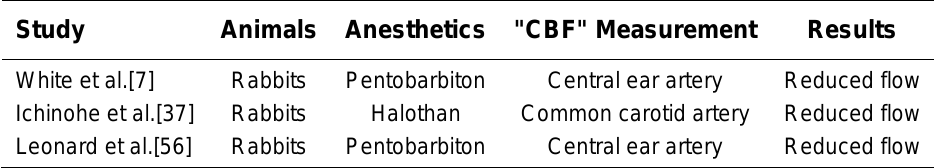
Summary of Previous Animal Studies Investigating Cerebral Hemodynamic Changes after Initation of the